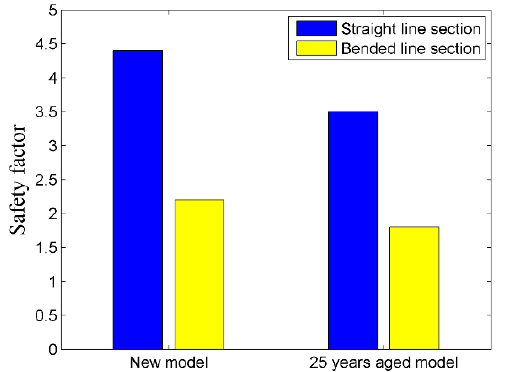
Figure 14. Safety factor (SF) comparison of new and aged models of the proposed scheme regarding straight and bended enclosure segments.